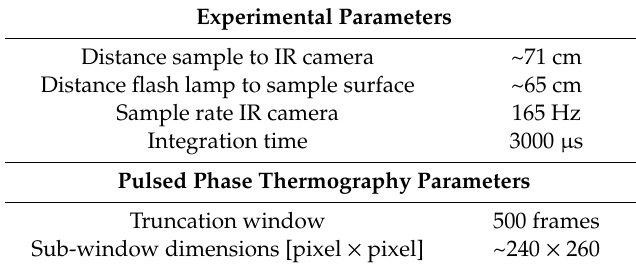
Table 3. Pulsed Thermography setup and Pulsed Phase algorithm